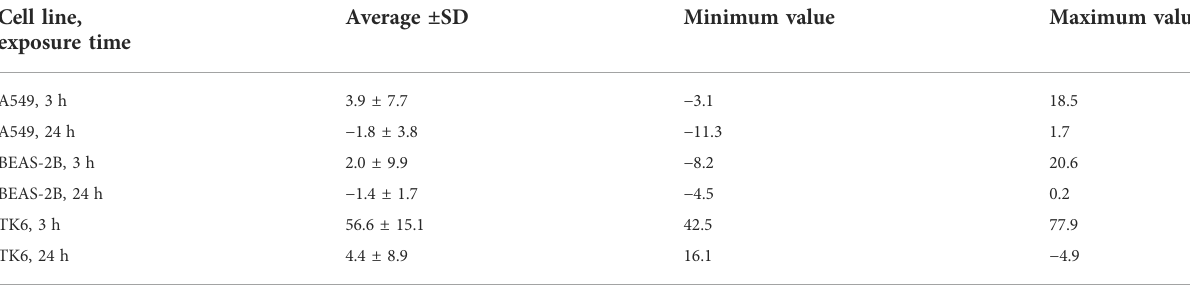
TABLE 2 Historical PC data for Chlorpromazine 50 µM (by cell lines and exposure time). Data are reported as relative fl uorescence intensity (%) with respect to the NC (100%). Cell line, exposure